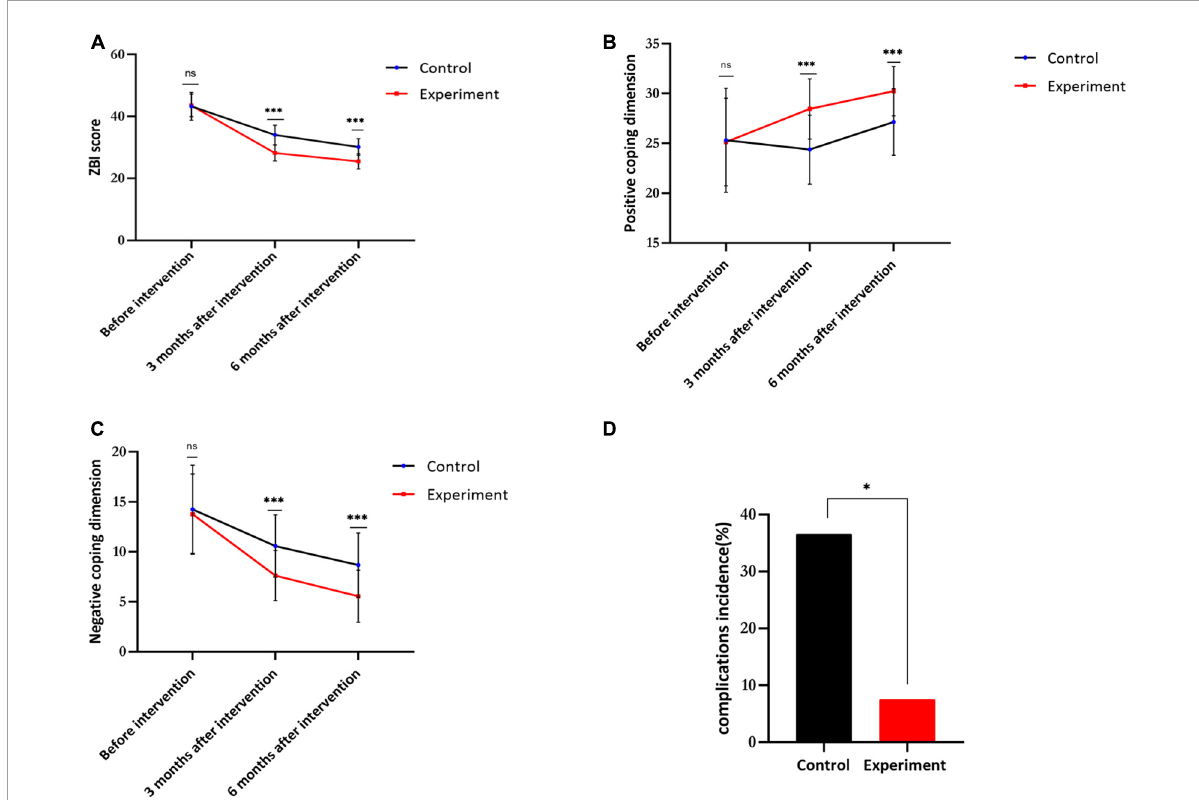
FIGURE3 Visualization of the results of this study. (A) The Zarit Caregiver burden interview (ZBI) score of control and experiment groups. (B) The positive coping dimension of control and experiment group. (C) The negative coping dimension of control and experiment groups. (D) The complications incidence of control and experiment groups ( n = 40, * p < 0.05, ** p < 0.01; *** p < 0.001; ns,